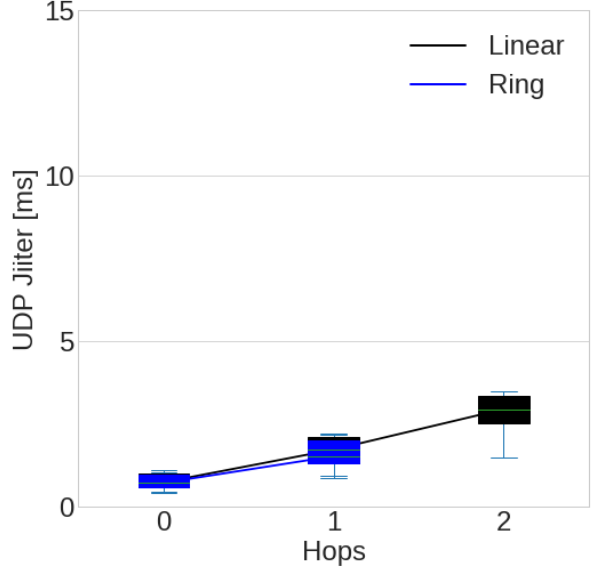
Figure 31. CityLab UDP jitter.